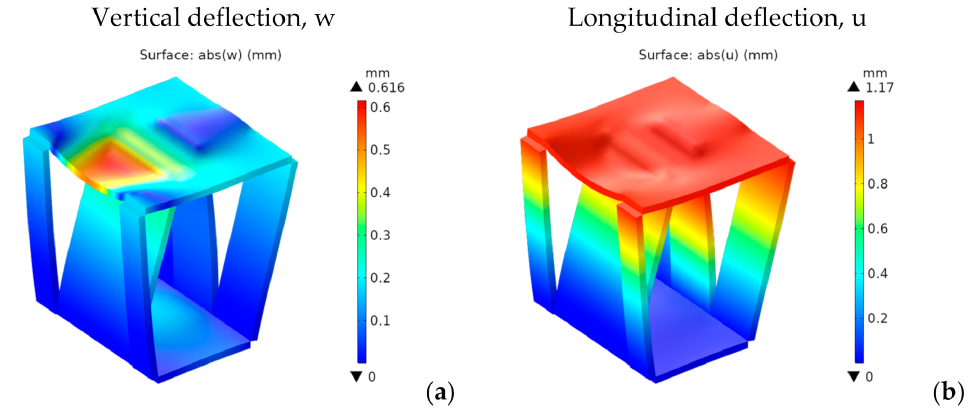
Figure 25. 4th design. Deflections for ply orientation I [mm]: ( a ) vertical, w; ( b ) longitudinal, u. The trend showing lower vertical deflections for orientation I than for orientation II is maintained. For orientation I, they show an almost trapezoidal shape. For orientation II, they show an almost cylindrical shape placed on the front side of the stool, with its axis oriented from side to side. Maximum vertical and longitudinal deflections for orientation I are 0.6 and 1.2 mm, respectively, these being quite